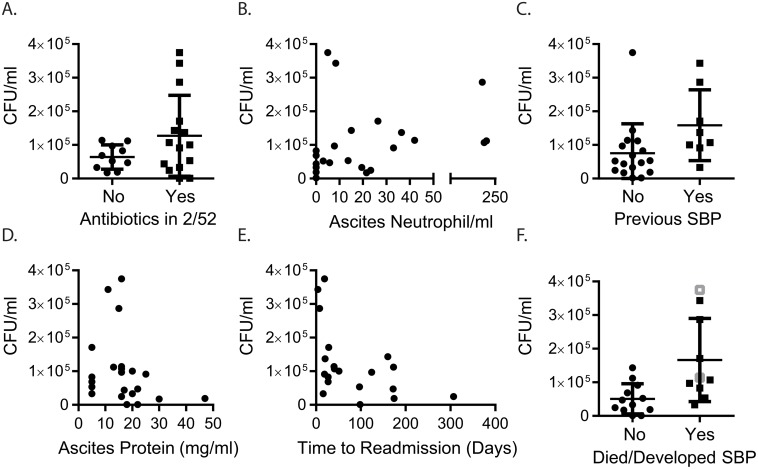
Bacterial DNA burden in ascitic fluid is associated with poor clinical outcomes.(A) Ascitic bacterial DNA burden in patients who had received antibiotics within the previous 2 weeks (2/52) (p = 0.28). (B) Correlation between bacterial DNA burden and the number of neutrophils/ml ascitic fluid (rs = 0.5, p = 0.012). (C) Bacterial DNA burden in patients with a previous history of SBP (p = 0.027). Correlation between bacterial DNA burden and (D) ascites total protein content (rs = -0.42, p = 0.045) and (E) time to hospital readmission (rs = -0.50, p = 0.024). (F) Bacterial DNA burden in patients who survived and those who died (black squares) or developed SBP (grey squares, # developed SBP and died, p = 0.006).